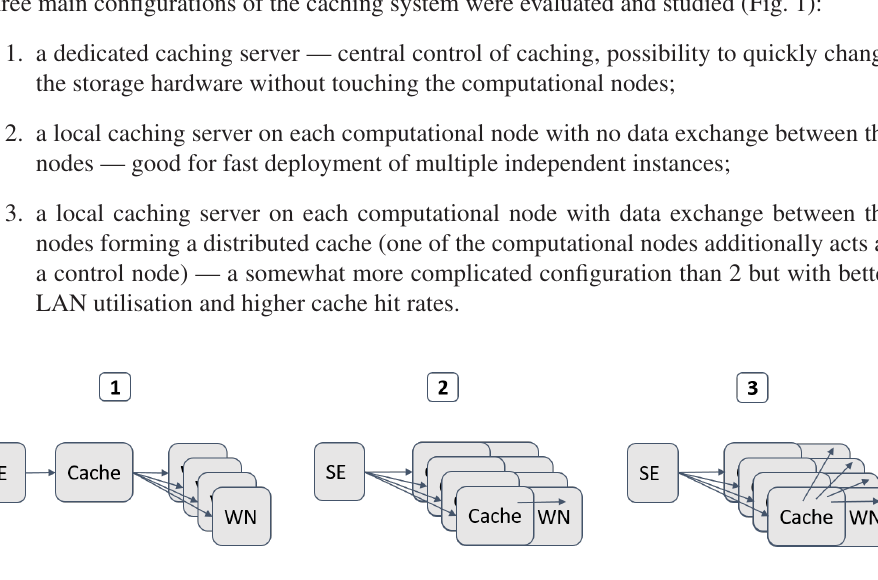
Figure 1. The caching system